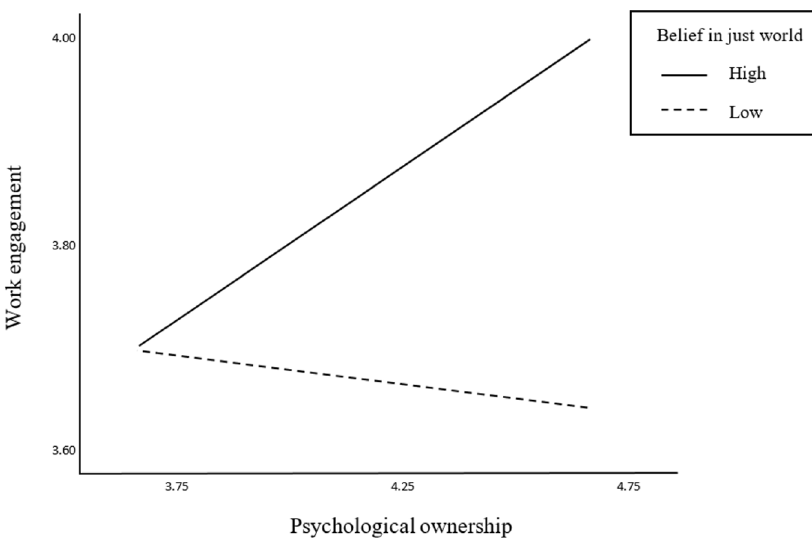
Figure 1. Moderating role of belief in just